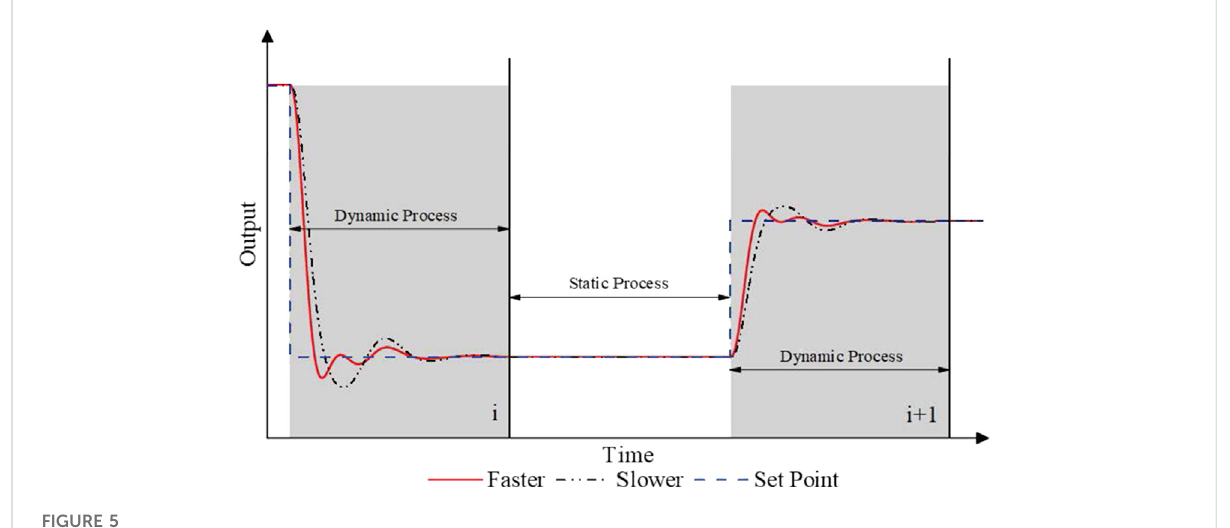
FIGURE 5 Layered architecture for RE-HES con fi guration